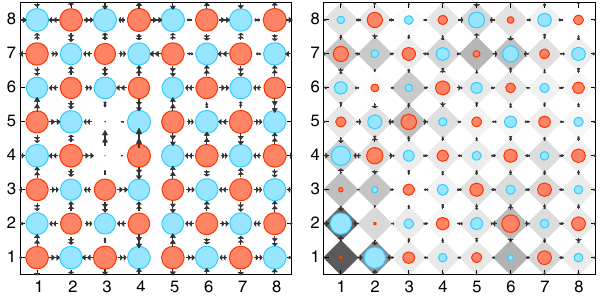
FIG. 14. Field plots from a TTN numerical simulation of 8 × 8 systems. The left panel depicts a configuration corresponding to a local minimum in the total energy in which a simulation got stuck because of a poor choice of the penalty parameter ν . The right panel shows the field plot for a typical randomly initialized state. Note that in this case, the link symmetry is not respected. The gray diamonds in the background of each site signal the violation of this constraint. The darkness of the gray color corresponds to the contribution of the penalty term in Eq. (E1) for the site positioned at x ≡ ð i; j Þ